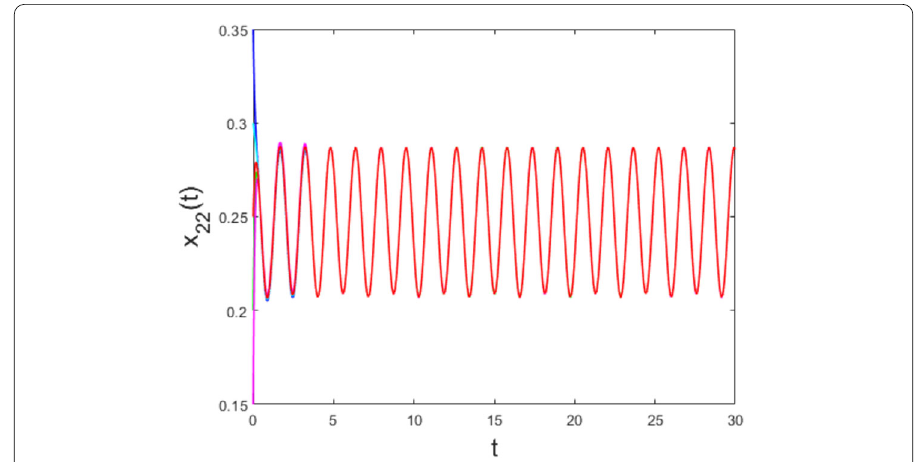
Figure 4 The state trajectory x 22 ( t ) of the network (11) with the initial conditions x 22 ( t ) = 0.15,0.2,0.25,0.3,and 0.35for t ∈ [–1,0]. It is seen that the FSICNN (11) has a globally exponentially stable π -periodic